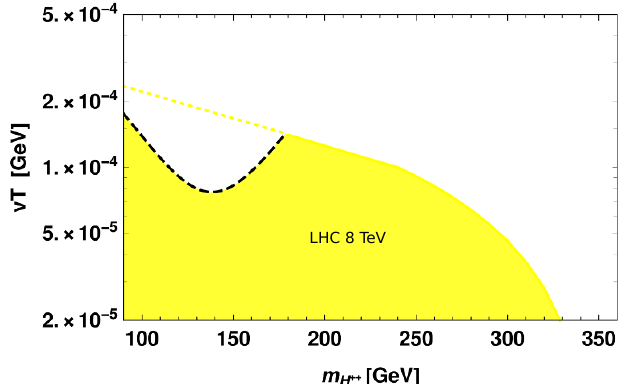
Figure 7 . Parameter space constraints from prompt LHC ( p s = 8 TeV) searches for same-sign dileptons at 95% con(cid:12)dence level [22], taking the possible displacement into account. The dashed black line indicates where the e(cid:11)ective cross section is smaller than the observed limit. The dotted yellow line shows where the limit from the prompt search would be if all decays were